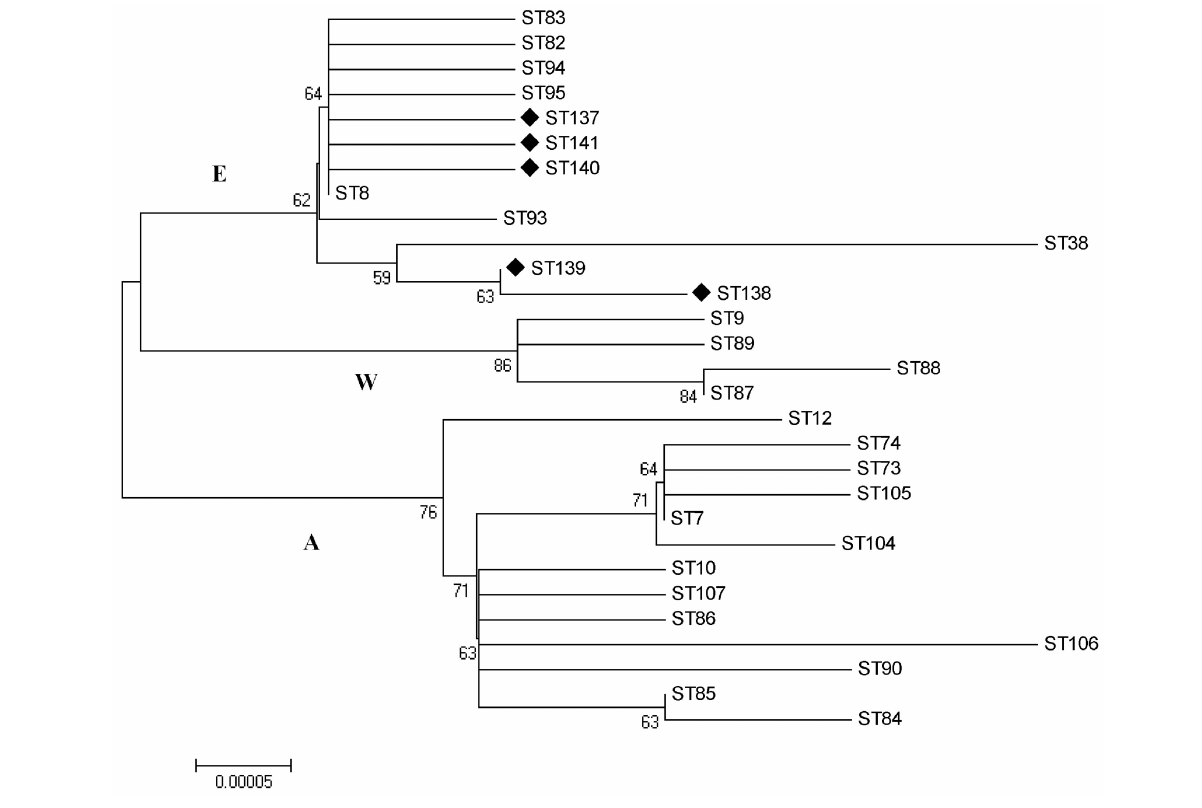
FigUre 2 | Phylogenetic analysis of newly detected ST137, ST138, ST139, ST140 and ST141 together with 24 sequence types (STs) previously reported in Brucella melitensis . In the phylogenetic tree, distinct three clades were observed, with A standing for America/Africa lineage, W and E for West Mediterranean and East Mediterranean